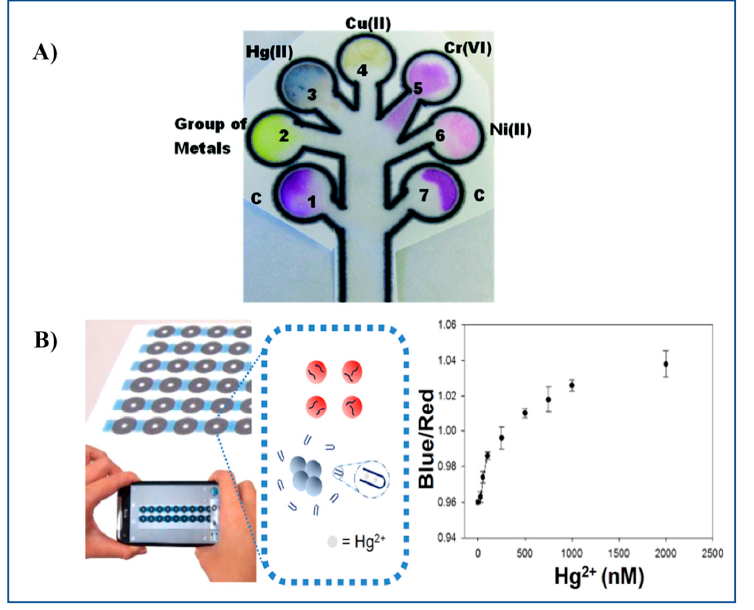
Figure 3. Representative examples of a microPAD and a PAD. ( A ) 2D microPAD for multiplexed detection of Hg(II), Cu(II), Cr(VI), and Ni(II) using Zincon, sodium diethyldithiocarbamate, 1,5-diphenylcarbazide and dimethylglyoxime as chromogenic reagents, respectively. The microPAD was employed to detect individual metal ions or a mixture of metal ions on the basis of an enzyme-based assay ( β -galactosidase) [32]. ( B ) Detection of Hg(II) ions by a PAD based on the aggregation of ssDNA-attached AuNPs [47]. Figure 3A,B reproduced with permission of the American Chemical Society [32,47]